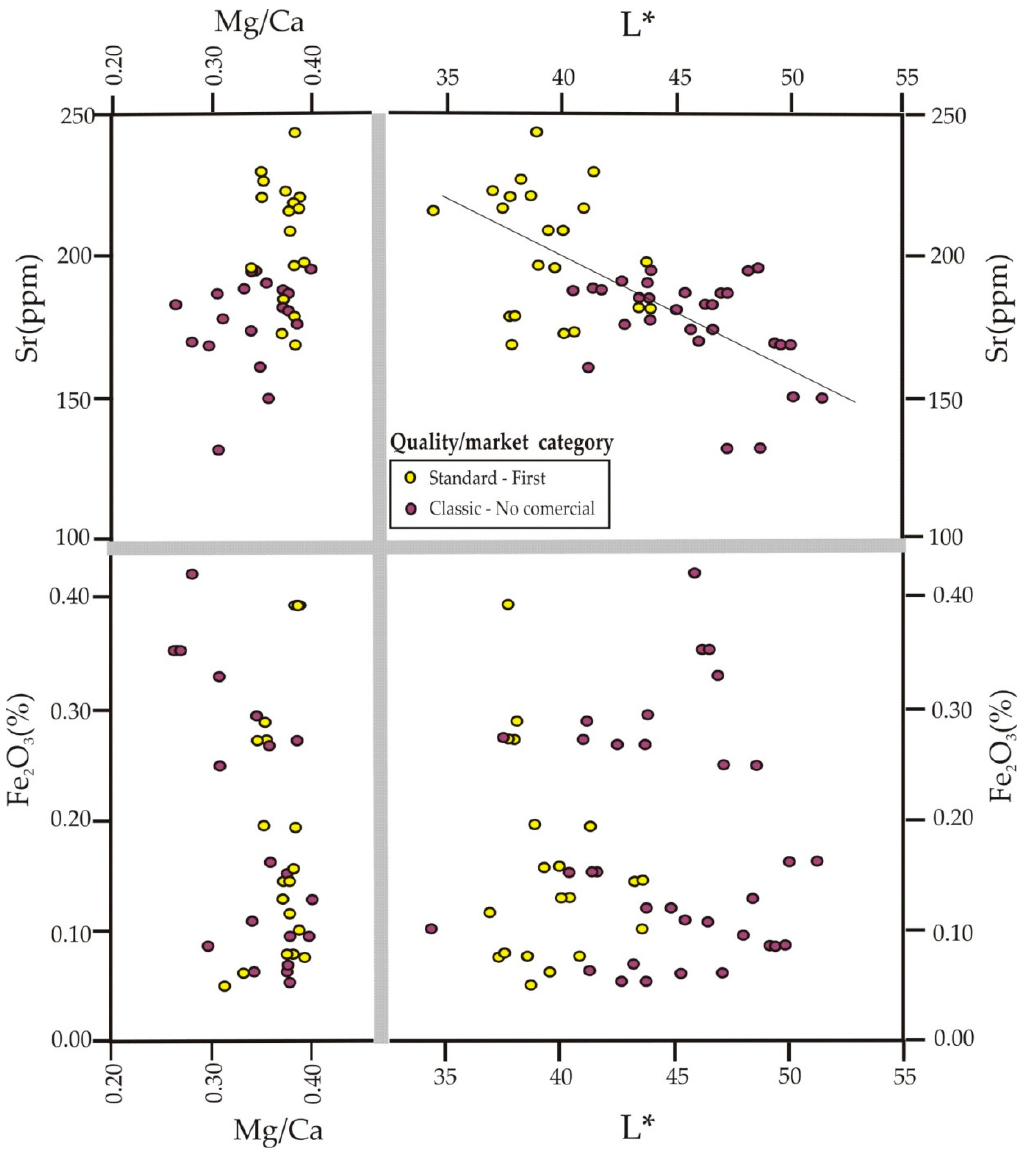
Figure 12. Sr y Fe 2 O 3 vs. L* and Mg/Ca plot showing the relationship between the chemical composition of the ME dolostones and their commercial